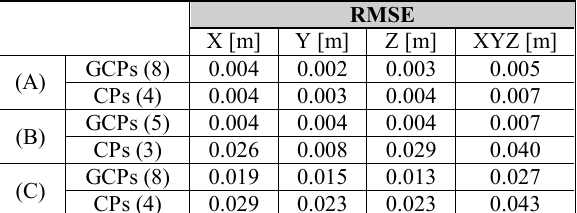
Table 6 . Mean residuals on GCPs and CPs (parabolic arch